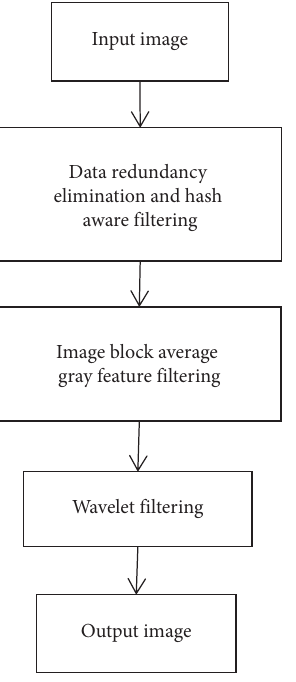
Figure 1: Image redundancy